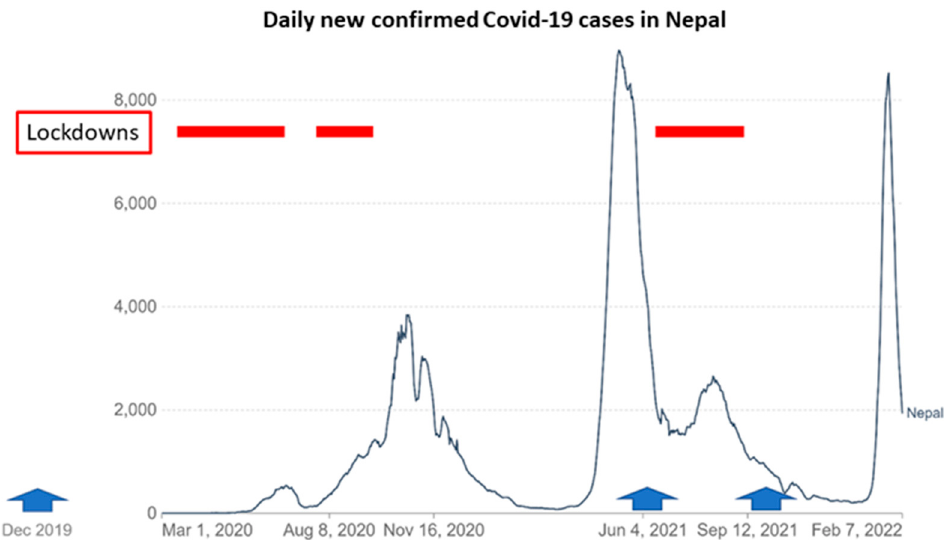
Figure 1. Daily new confirmed COVID-19 cases in Nepal March 2020–2022. Red bars indicate national lockdowns. Blue arrows indicate the three rounds of data collection. The second round survey was conducted in part via telephone. Graph is modified from Data source: Johns Hopkins University CSSE COVID-19 Data. Graphic prepared by Our World in Data (open access) [53].